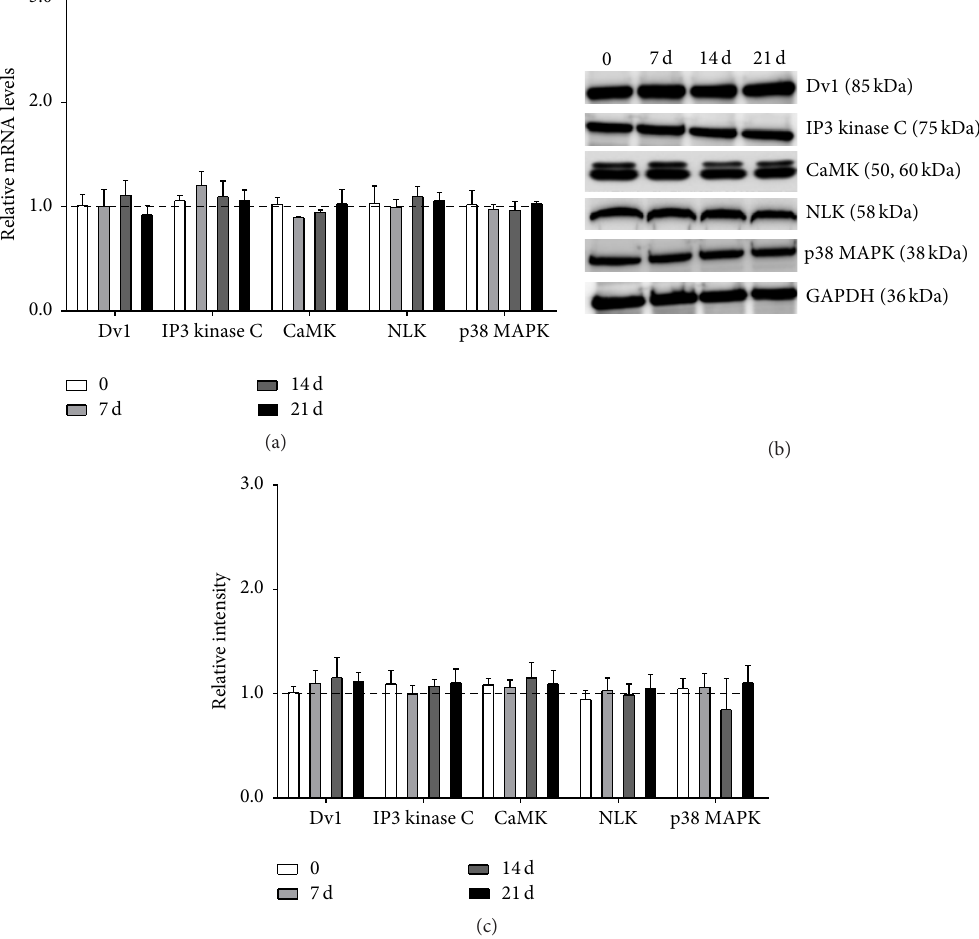
Figure 7: Wnt/Ca 2+ pathway was not involved in the differentiation of PDLSCs promoted by ET-1. RNA and proteins were extracted after PDLSCs had been treated with 10nM ET-1 for 12 h, 24 h, and 72 h and 7d, 14d, and 21 d. And the levels of each mRNA (Dv1, IP3 kinase C, CaMK, NLK, and p38 MAPK) were measured. None of the above genes showed any change after ET-1 treatment (a), nor did the protein levels ((b) and (c)). These results indicated that Wnt/Ca 2+ pathway was not involved in the differentiation of PDLSCs promoted by ET-1. Each bar represents the mean ± standard deviation ( 𝑛 = 3